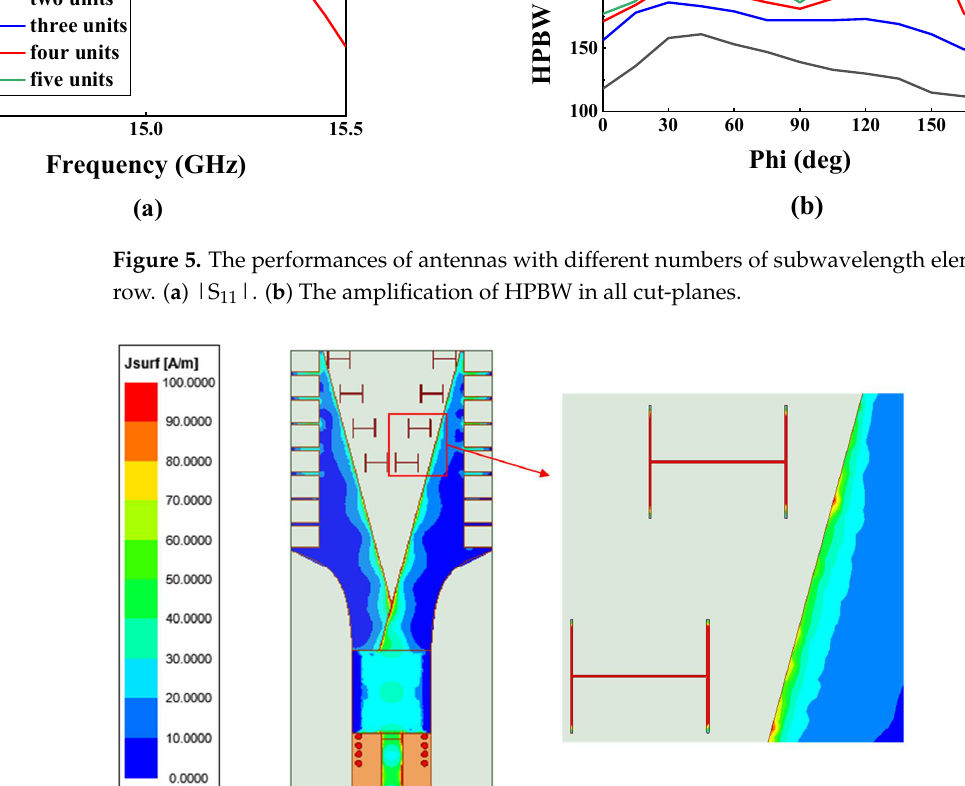
Table 2. E−field amplitude and phase distributions of the proposed and basic antennas.